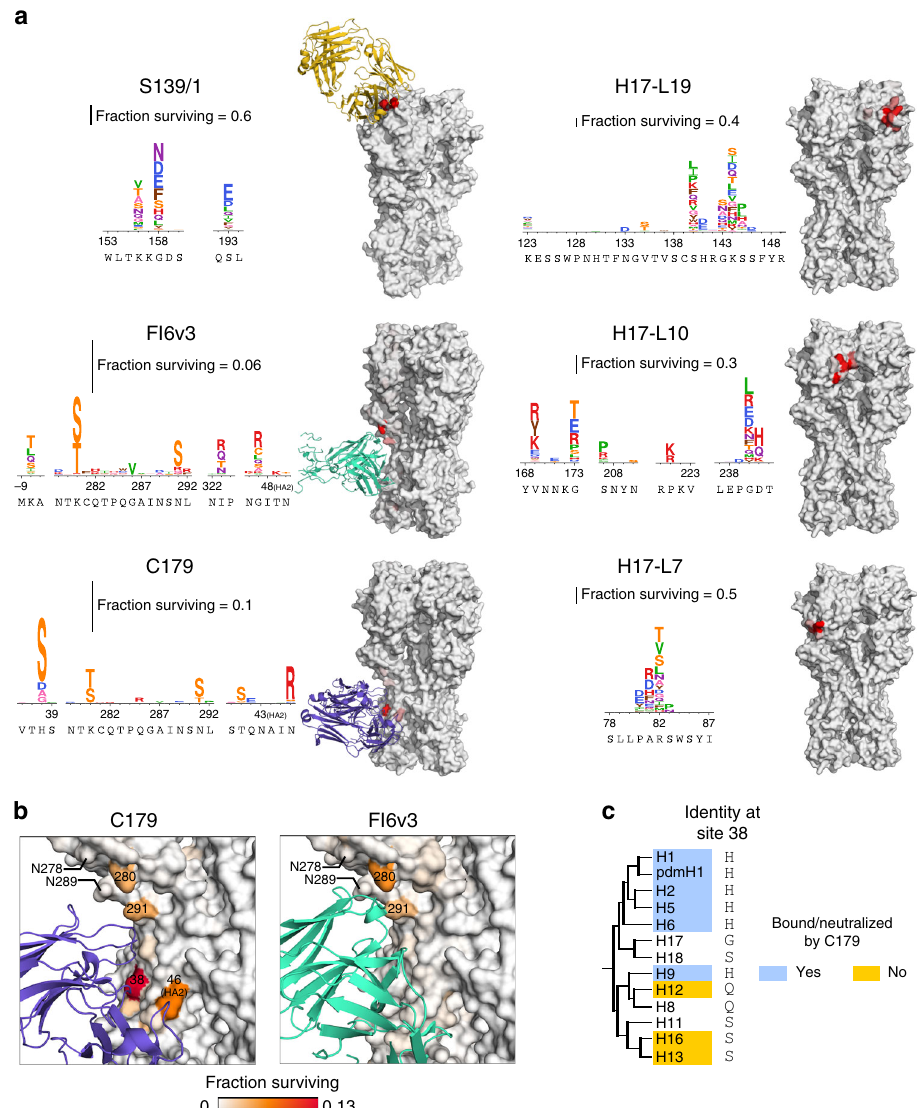
Fig. 5 Mutations selected by broad and narrow antibodies. a Logo plots show sites where mutations have the largest effect. Letter heights are proportional to the excess fraction of virions with that mutation that survive antibody, as indicated by the scale bars. Structures are colored white to red by the excess fraction surviving for the largest-effect mutation at each site, with each antibody scaled separately. b Sites of selection from anti-stalk antibodies, with the same coloring scale for both antibodies. Selection for serine or threonine at sites 280 and 291 introduces glycosylation sites at 278 and 289, respectively. c Cladogram of group 1 HA subtypes. The amino acid at site 38 is indicated. Colors indicate whether a subtype has been reported in the literature to be bound or neutralized by